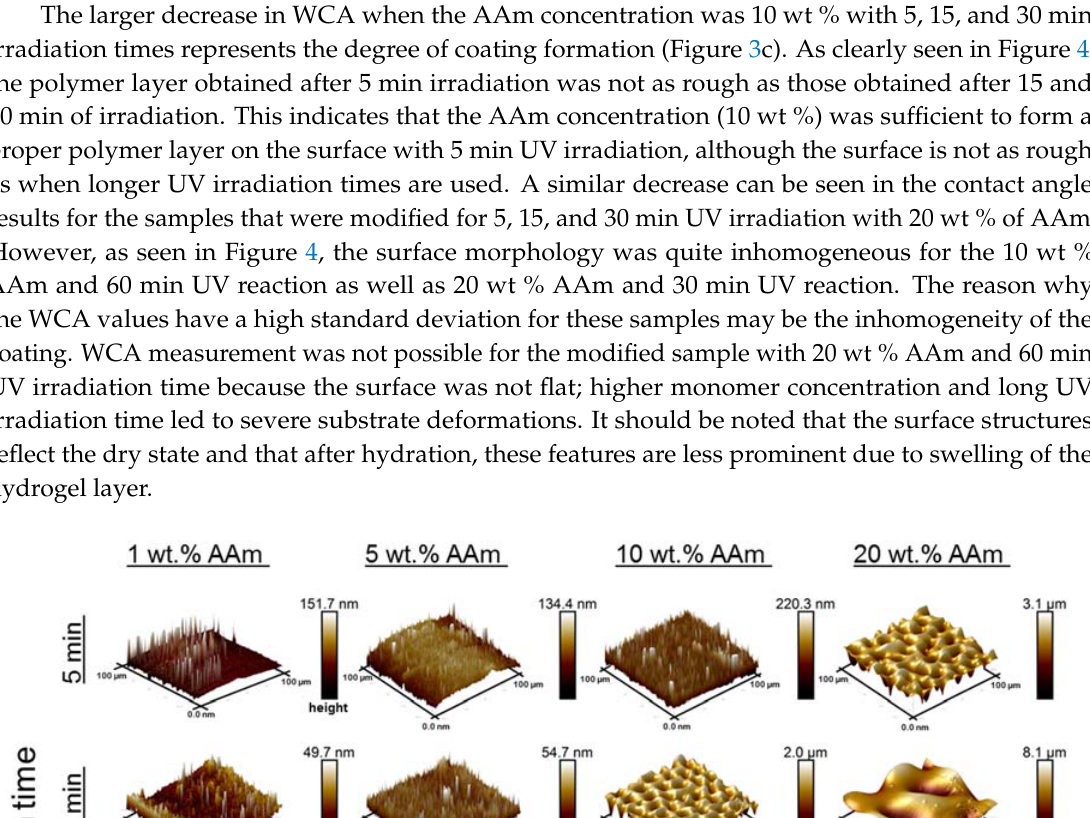
Figure 5. Scheme of Si amount determination from a cross section image of a coated PDMS surface obtained by SEM ‐ EDX.